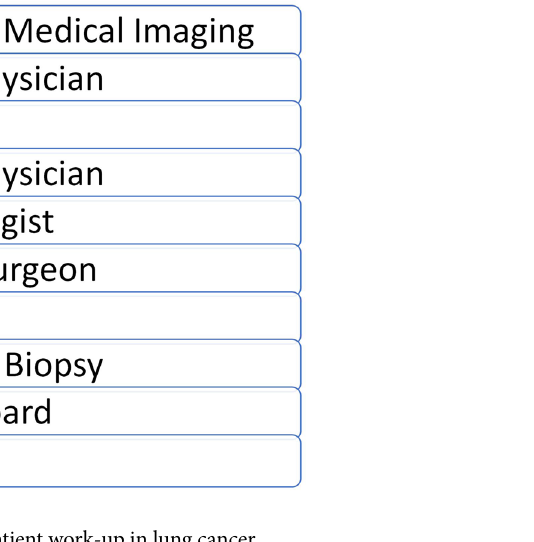
Figure 5. Sub-processes for patient work-up in lung